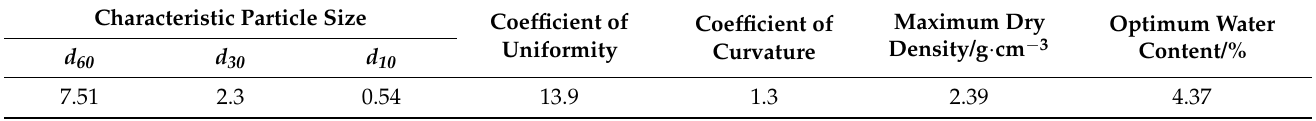
Figure 3. Particle gradation curve of typical coarse-grained soil in Xinjiang, China. Table 1. Physical and mechanical properties index of coarse-grained soil.